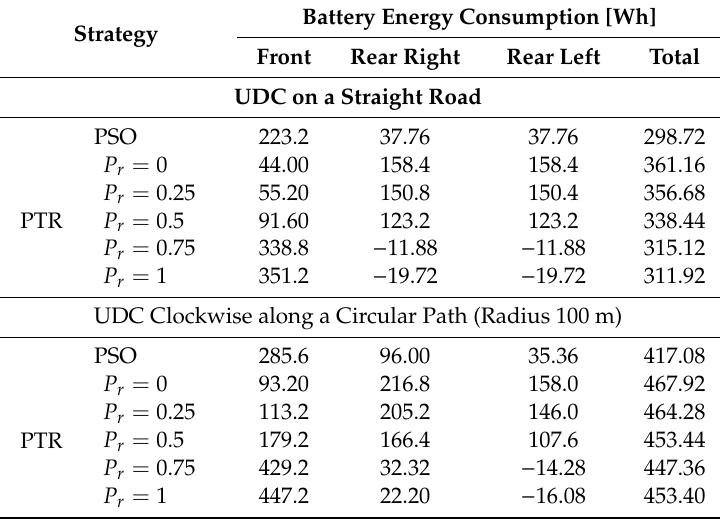
Table 2. Energy consumption of battery